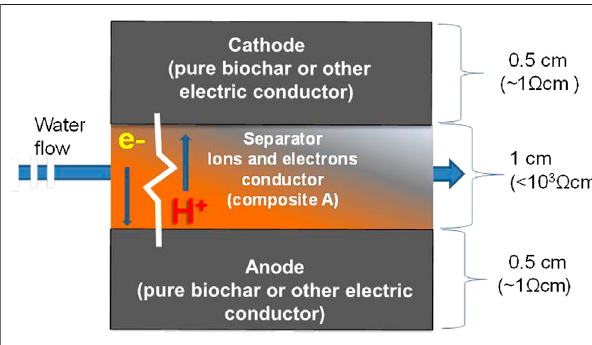
FIGURE8| SchematicofacompositesolidMESunit,whoseelectrodes are physically separated by a composite A made of a suitable mix of biochar and terracotta having an electrical resistance of about 1 k Ω